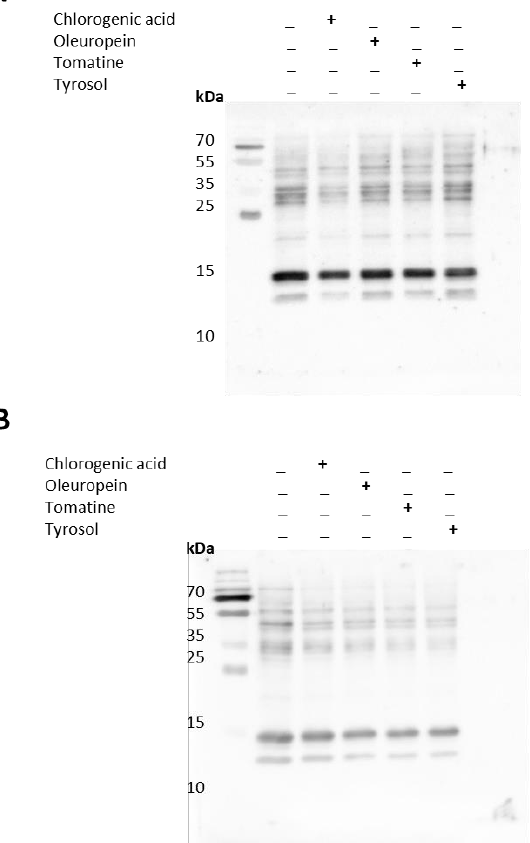
Figure 6. Identification of protein MDA adducts in whole-cell homogenates of U-937 cells treated with bioactive compounds PMA or PMA + bioactive compounds. Anti-MDA blot represents protein modification in U-937 cells differentiated for 48 h ( A ) and 72 h ( B ).